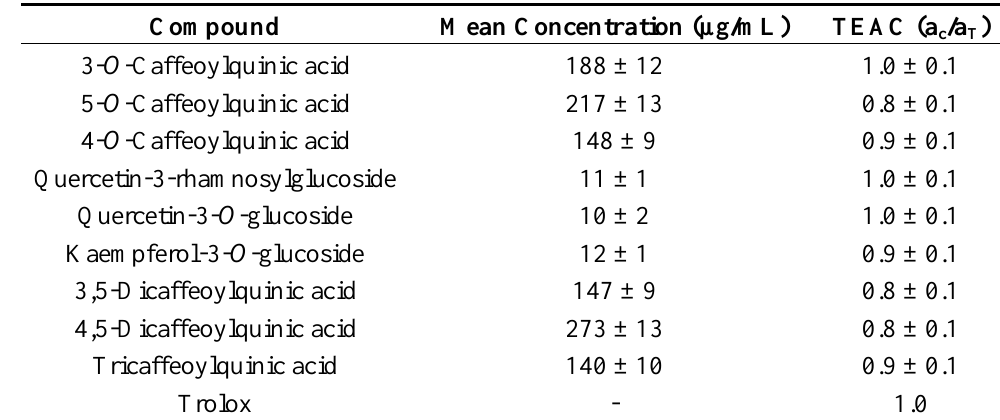
Table 3. Individual antioxidant capacity of the phenolic compounds of the beverage chimarrão of Ilex